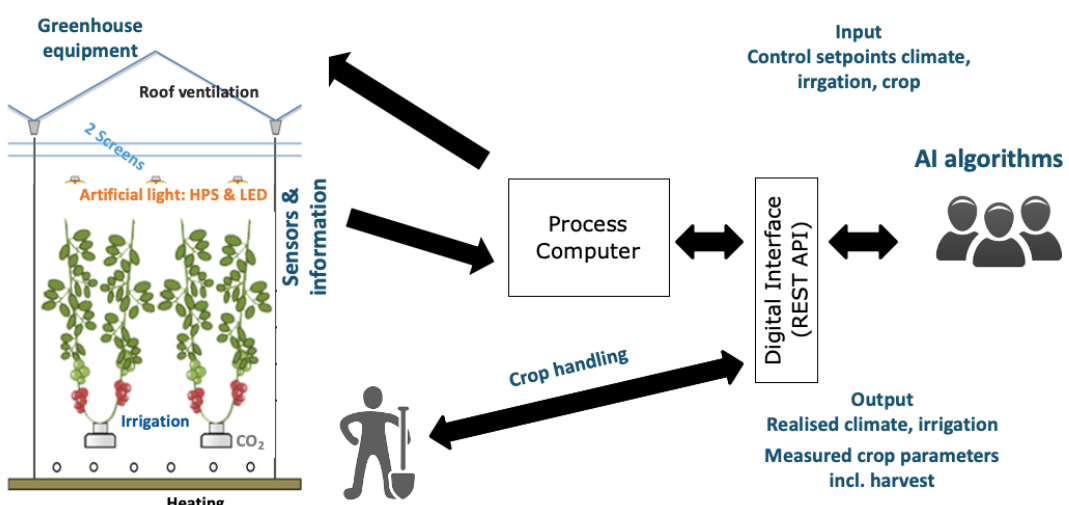
Figure 2. Scheme of data exchange from the teams and their AI algorithm via a digital interface (REST API) towards the process computer and the greenhouse actuators and data from sensors via the same way back, data exchange between teams and workers on crop handling, and measured crop parameters. Principle of the set-up earlier described in [58].